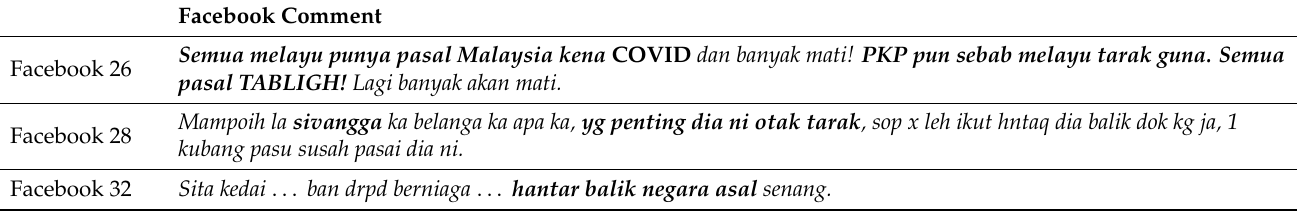
(Bolding shows words stigmatizing COVID-19 patients). Table A3. Examples of stigmatization of COVID-19 patients from certain social classes in Facebook comments (N = 2).